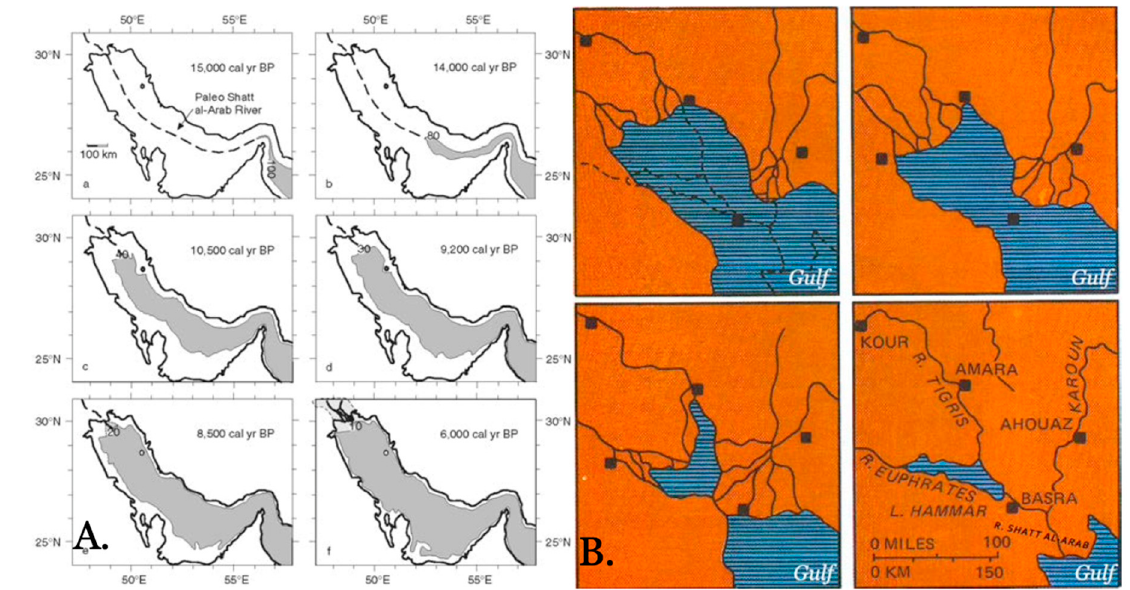
Figure 8. ( A ) Progression of marine water into the Gulf basin from the Pleistocene to the early Holocene, including the position of a precursor to the Shatt al-Arab that once emptied directly into today’s Gulf of Oman (modified from [59]). For scale, see Figure 7. ( B ) From left to right and top to bottom, hypothetical geomorphodynamics of the formation of the modern deltaic complex during the Middle-Late Holocene: 5000 BP, 4000 BP, 3000 BP, and 2000 BP (modified from [101]).